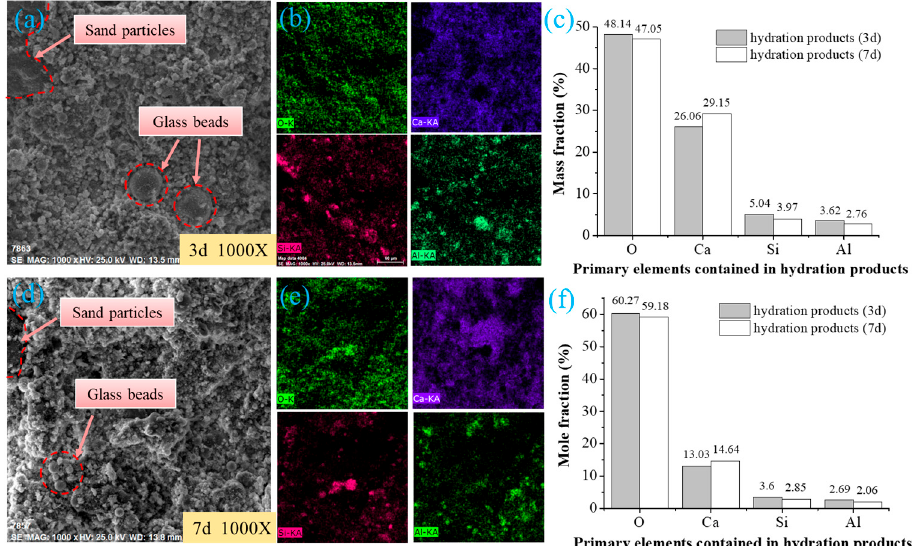
Figure 16. Locations and testing results for selected surfaces for EDS surface element testing of hydration products with various curing times: ( a ) testing surfaces of energy spectrum for a curing time of 3 days; ( b ) element distributions in testing surfaces for a curing time of 3 days; ( c ) element contents in testing surfaces (wt. %); ( d ) testing surfaces of energy spectrum for a curing time of 7 days; ( e ) element distributions in testing surfaces for a curing time of 7 days; and ( f ) element contents